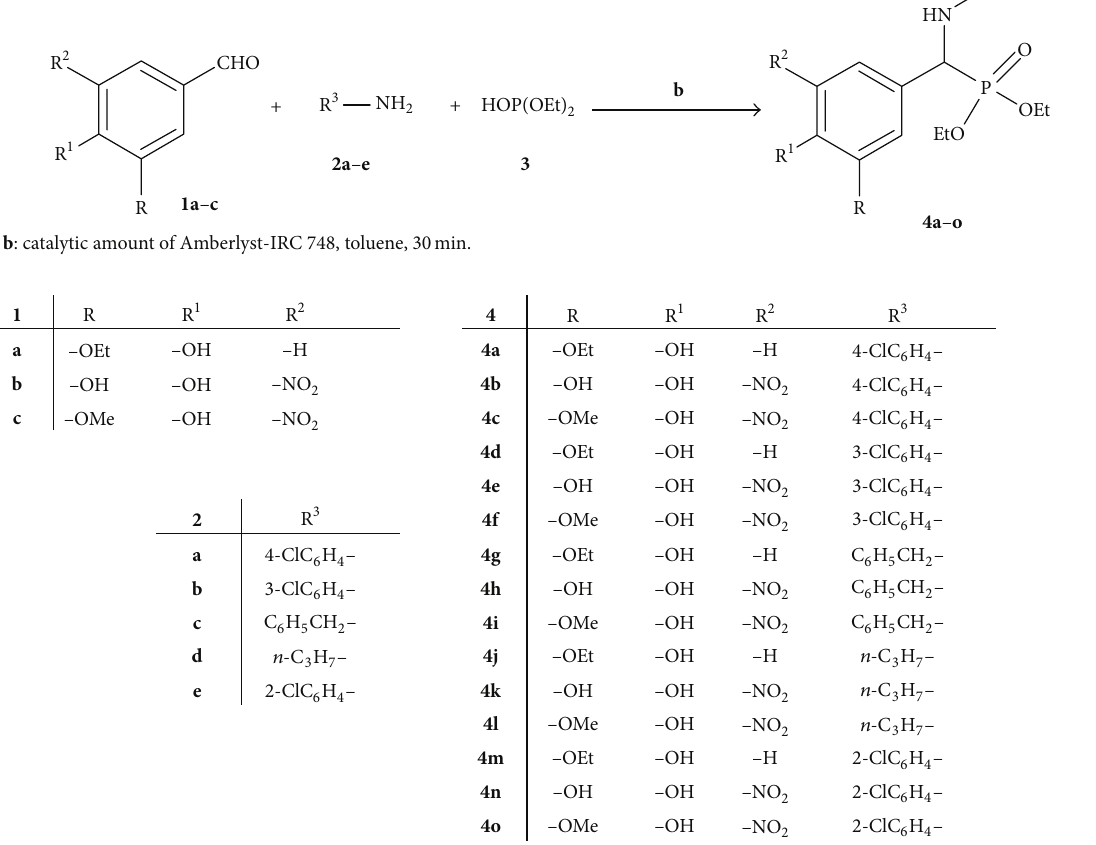
Scheme 2: Newly synthesized